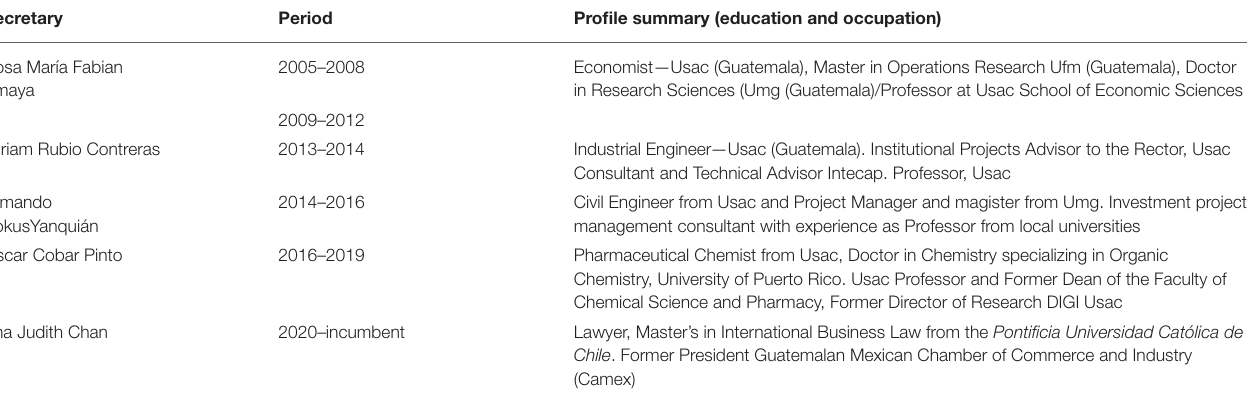
TABLE 1 | Participants from the policy perspective: secretaries of science and technology in Guatemala (2005–2020). Secretary